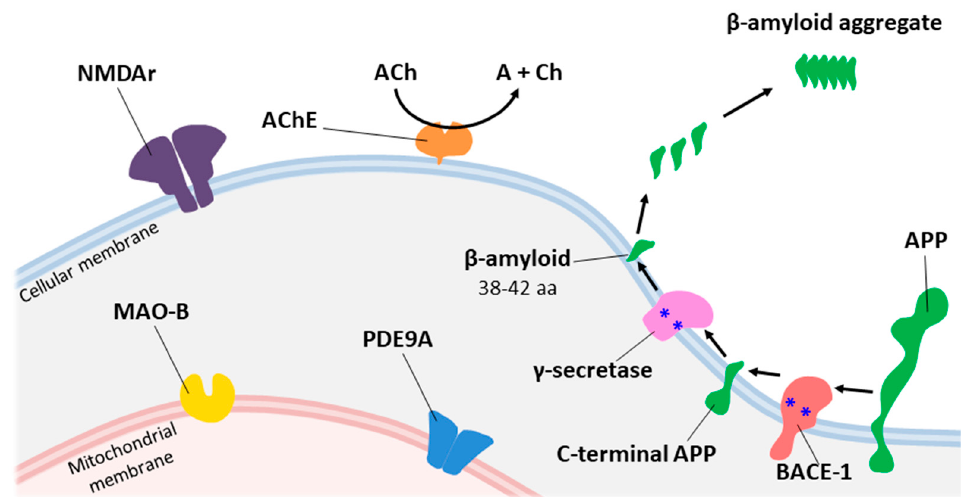
Figure 2. The major molecular targets in AD for MTDLs.